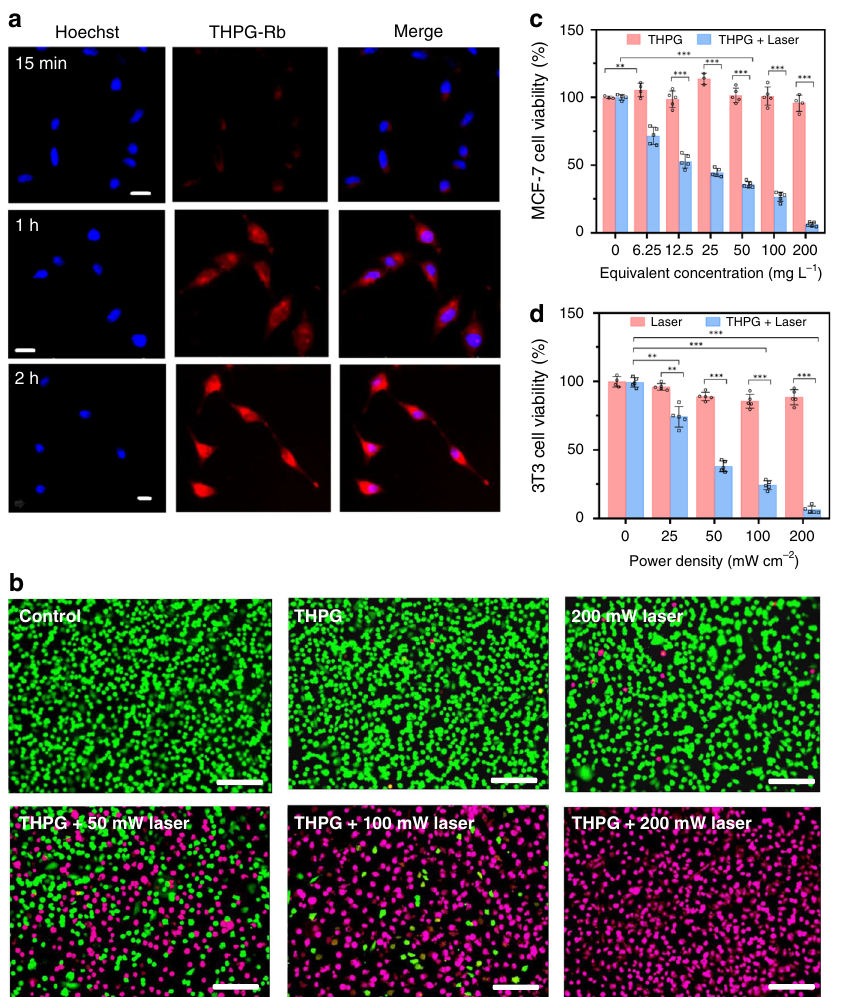
Fig. 5 In vitro cell evaluation of biosafety and photothermal effect of the THPG vesicles. a The representative CLSM images of cell uptake of THPG-Rb vesicles at various time points by MCF-7 cancer cells. The magenta pink color (recoloring from red color) originates from THPG-Rb vesicles and the blue color is from Hoechst in cell nuclei. The scale bar is 20 μ m. Similar images were obtained for more than two times experiments. b The representative CLSM images of MFC-7 cells co-stained by calcein AM and propidium iodide (PI) after various experiment conditions indicated. Green and red colors represented live and dead cells, respectively (Scale bar: 150 μ m). Similar images were obtained for more than two times experiments. c Relative viabilities of MCF-7 cells incubated with various THPG amount with or without 635 nm laser irradiation at 200 mW cm − 2 for 10 min ( n = 5 biologically independent cells). d Relative viabilities of MCF-7 cells with various laser irradiation power with or without THPG vesicle treatments ( n = 5 biologically independent cells). Data are presented as mean values + / − S.D., and P values are calculated by two-tailed Student ’ s t -test ** P < 0.005; *** P <